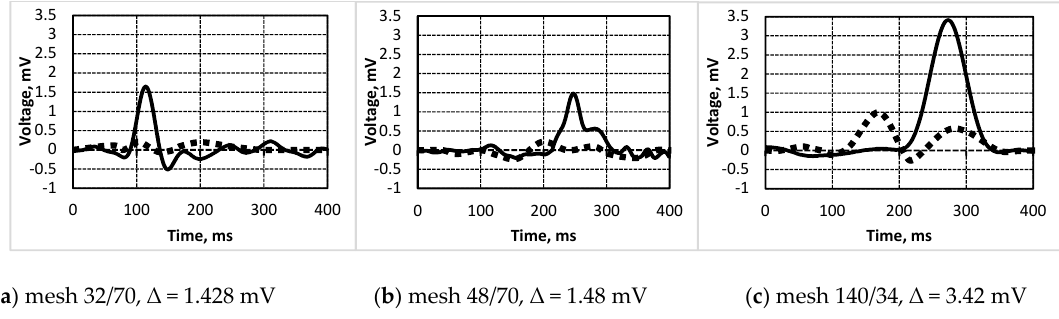
Figure 9. Generated voltage diagram of ( a ) Element 1 ( ― poled, ▪▪▪ not poled); ( b ) Element 2 ( ― poled, ▪▪▪ not poled); ( c ) Element 3 ( ― poled, ▪▪▪ not poled).